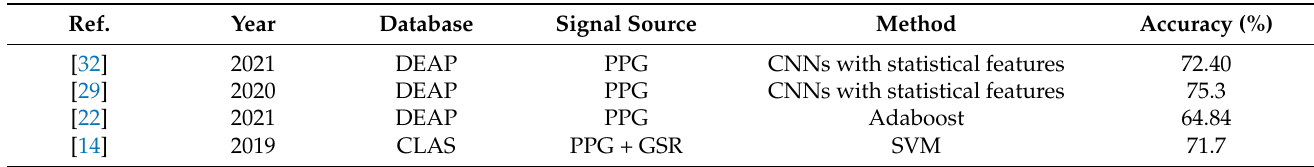
Table 11. Valence classification accuracies in previous